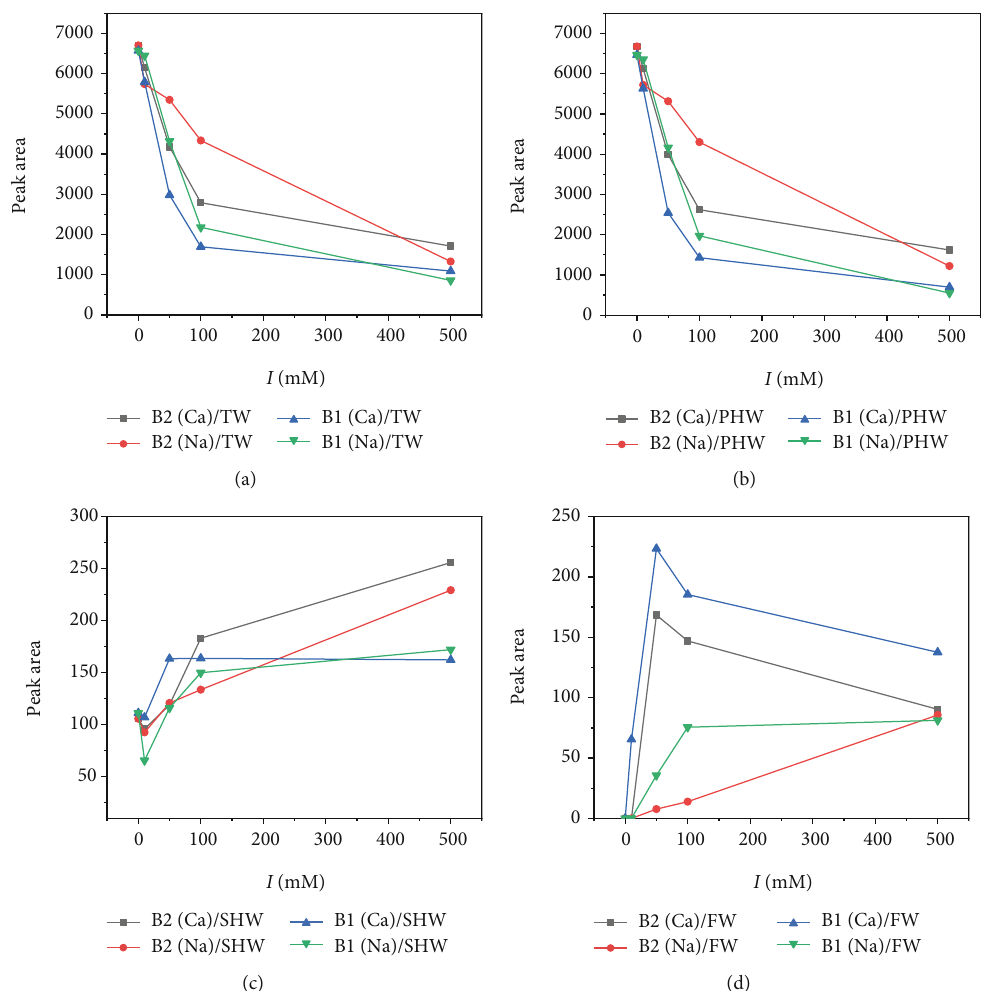
Figure 8: Relationship between ionic strength and peak area of di ff erent bound water types on surface of bentonite particles: (a) total water, (b) permeated hydration water, (c) surface hydration water, and (d) free